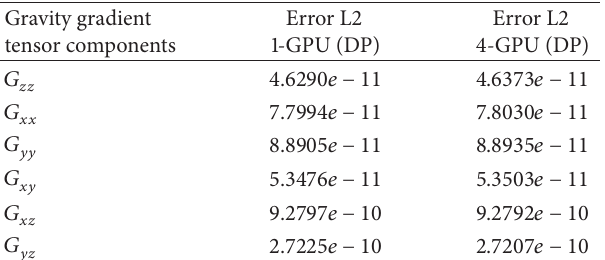
Table 3: Errors of the components of the gradient tensor of gravity in double precision, with respect to its sequential counterpart.